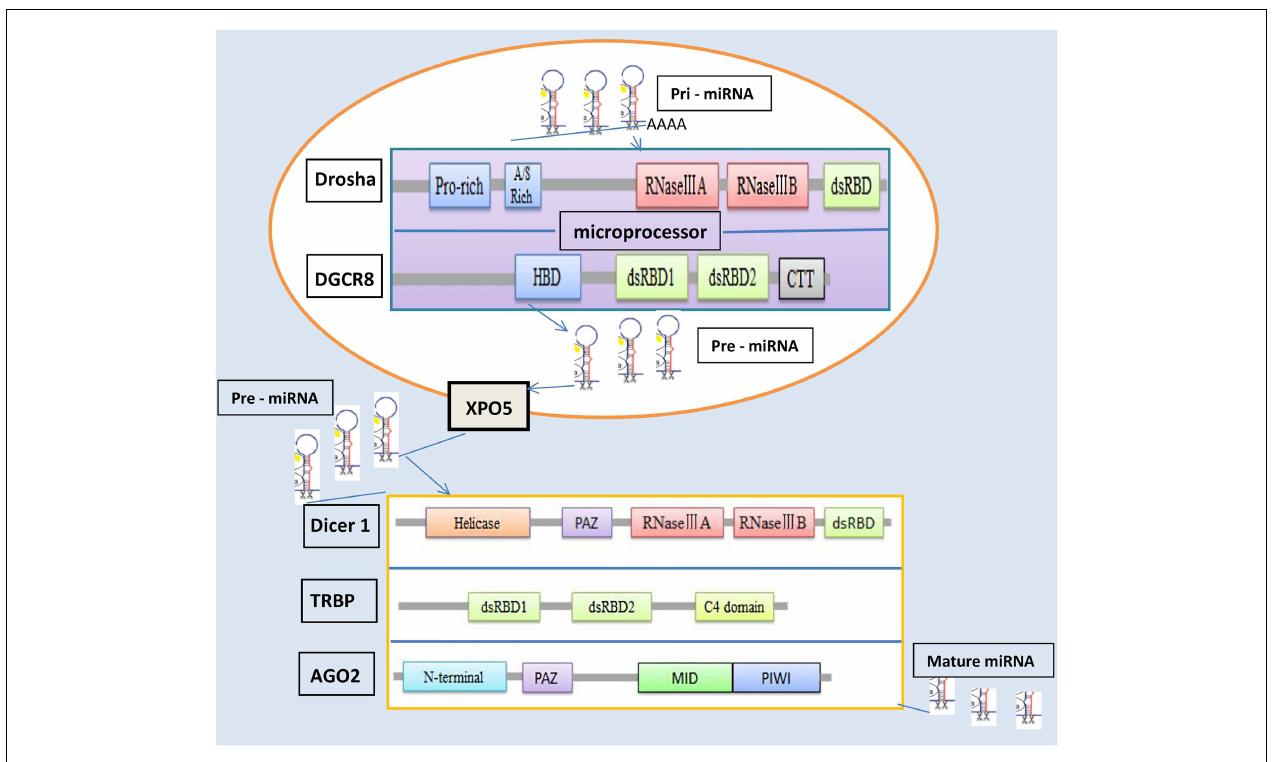
FIGURE 1 | Structure of microRNA machinery genes and miRNA biosynthesis